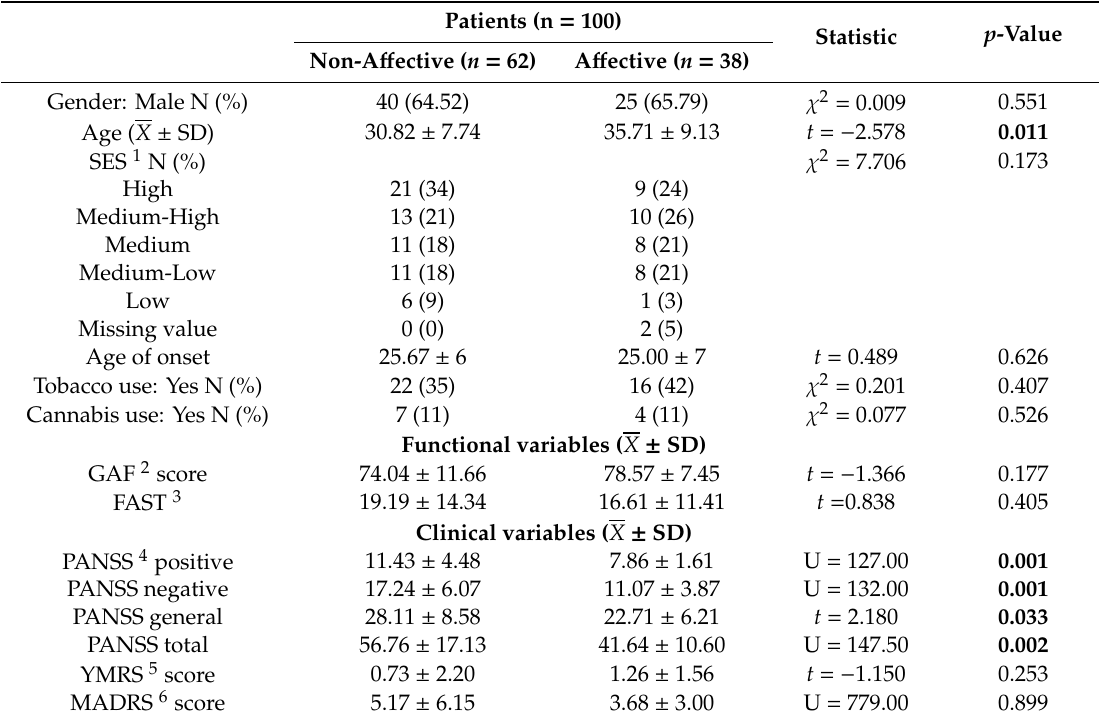
Table 2. Baseline sociodemographic, functional, clinical, and neuropsychological performance for patients (a ff ective vs. non-a ff